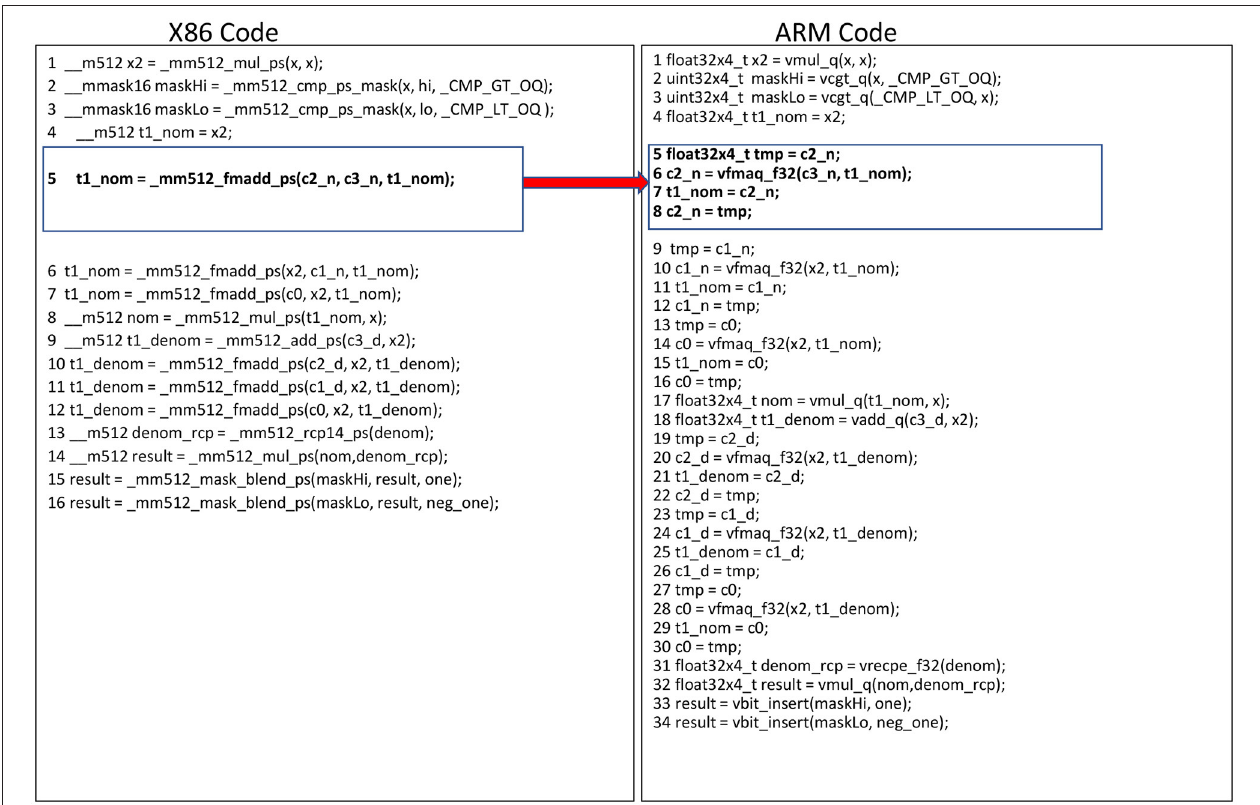
FIGURE 7 | Rational Padé 7/8 tanh approximation pseudocode with equivalent intrinsics on x86 and Arm/AArch64. We highlight here how the FMADD instruction on x86 ISAs has an equivalent instruction sequence on AArch64.